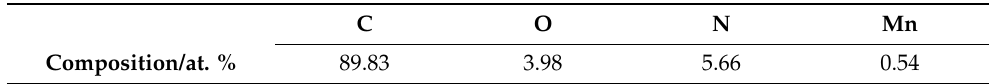
Table 1. Surface composition of Mn 3 O 4 @N-doped carbon determined by XPS. C O N Mn Composition/at. % 89.83 3.98 5.66 0.54